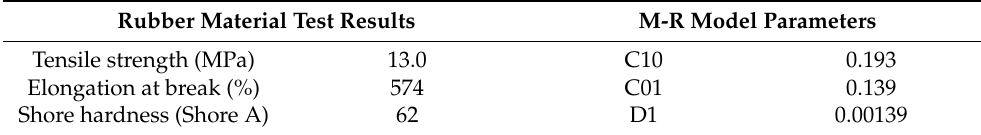
Table 2. Rubber material characteristics and parameter